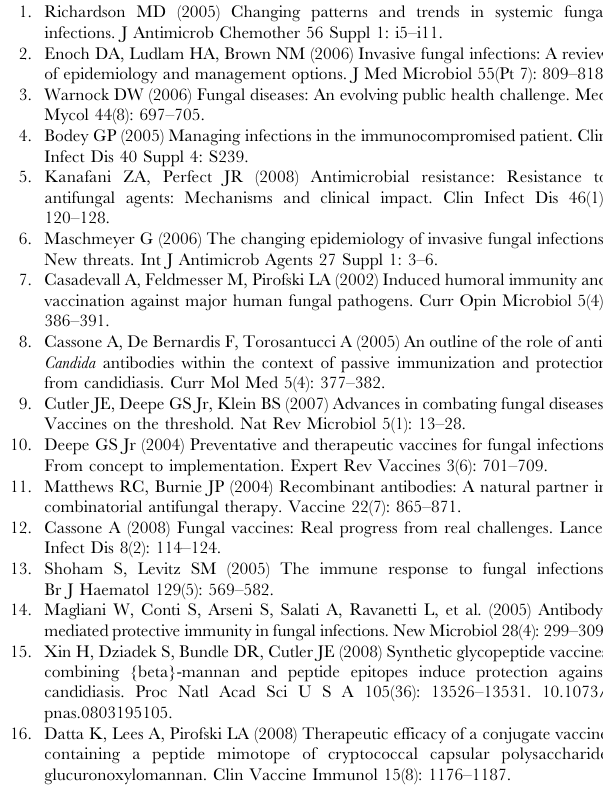
Figure S1 Concanavalin A- and IgG mAb-staining of hyphal secretion before and after periodate oxidation. Fungal secretions were treated 30 min with 0.1 M sodium periodate, dyalised by gel filtration and then compared to untreated secretion by SDS- PAGE and Western blot, followed by specific mannoprotein staining with digoxigenin-labelled Concanavalin A (Con-A) or the IgG anti- b 1,3-glucan mAb. Lanes 1 and 3: untreated fungal secretion; lanes 2 and 4: periodate-oxidised secretion. Samples loaded onto the gel correspond to 25 m g polysaccharide.